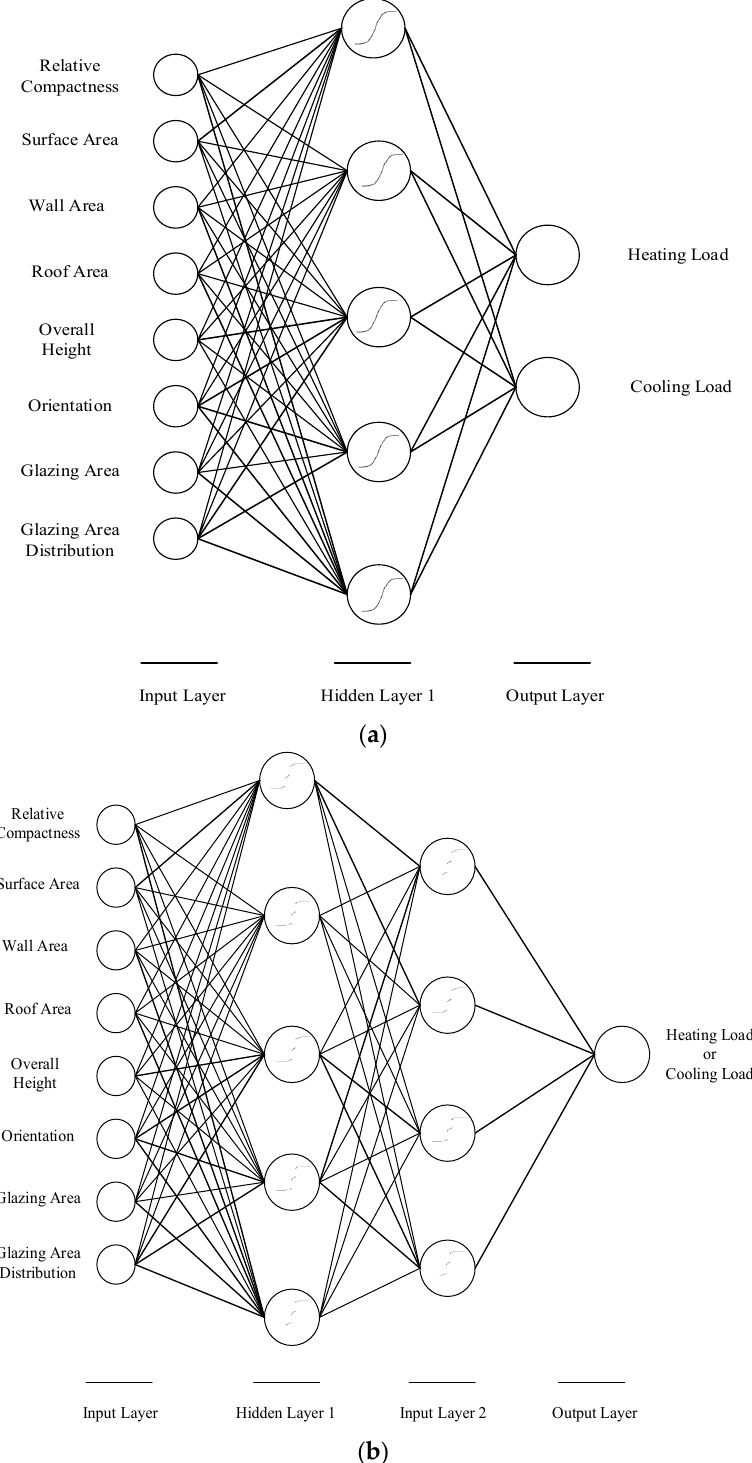
Figure 3. Graphical Representation of the Proposed DNN for ( a ) Experiments 1 and ( b ) Experiment 3 and 12. and